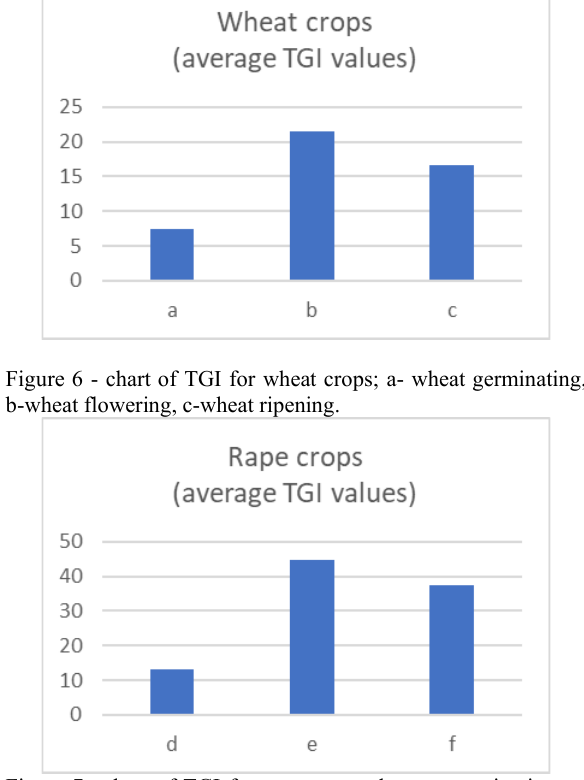
Figure 5 – VARI maps for rape crops (A – germinating, B – flowering, C – ripening)